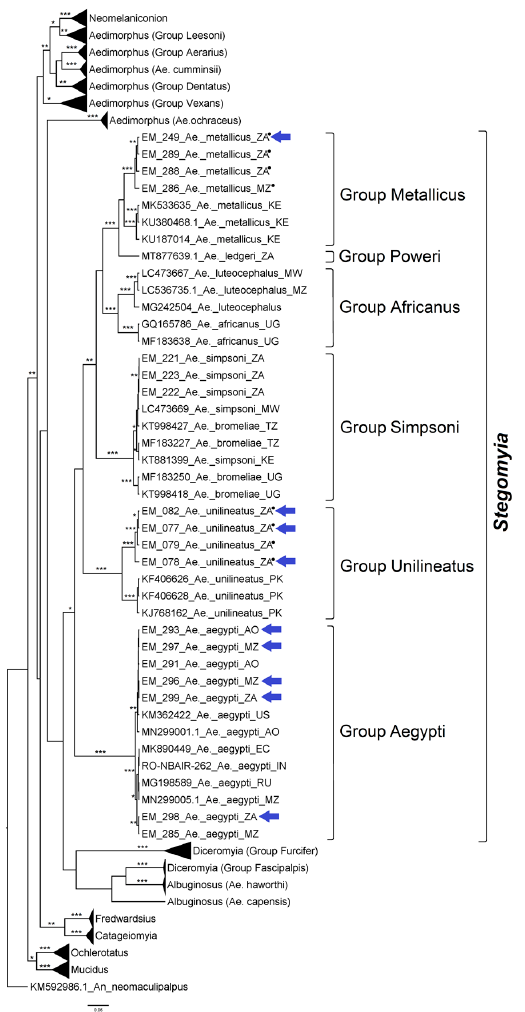
Figure 6. Phylogenetic analysis of 172 partial coxI nucleotide sequences from mosquitoes of the genus Aedes , presenting the subgenus Stegomyia . At specific branches, the number of * indicates the tree topological support revealed by the different phylogenetic reconstruction methods, assuming relevant bootstrap and aLRT values above 75% and posterior probability values above 0.80. The sequences obtained in this work are indicated with the “EM” code and those with associated genitalia are indicated by horizontal blue arrows. The sequences downloaded from GenBank and Boldsystems are indicated by their respective accession numbers and access codes (respectively); the symbol “.” after the code of our sequence indicates that said sequence was not identified by Boldsystems. Their country of origin [South Africa (ZA), Angola (AO), United States (US), Ecuador (EC),